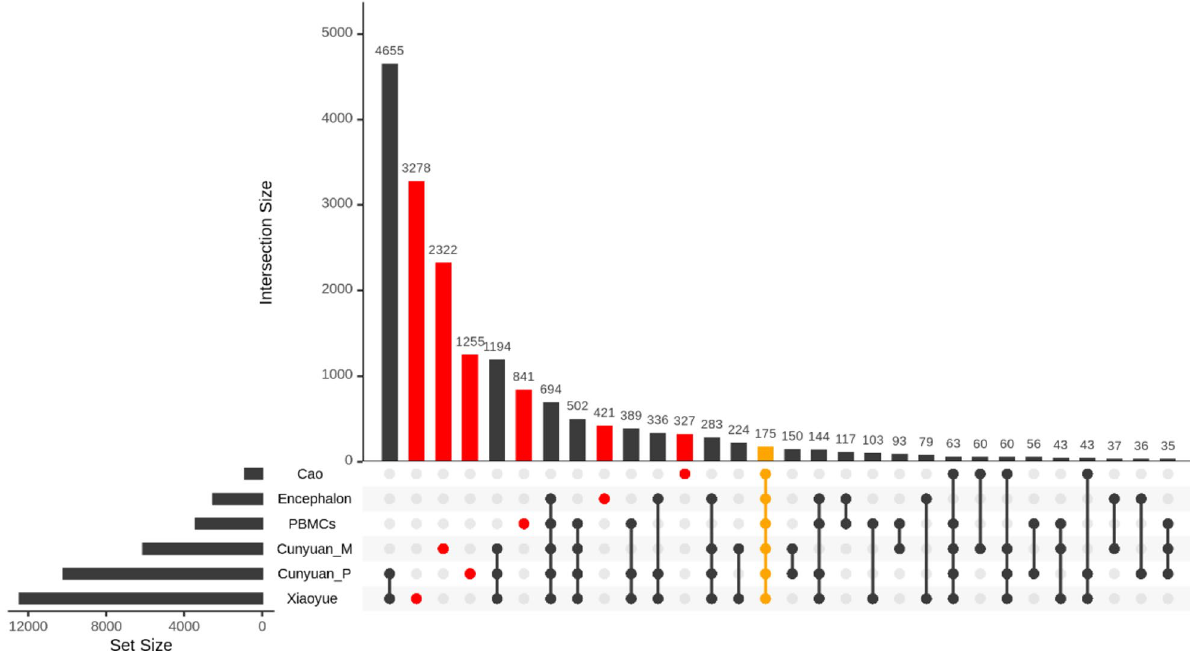
Figure 2. UpSet plot with the comparison of detected circRNAs in different studies. Encephalon and PBMCs refers to the circRNAs detected in this study, while Cunyuan_P (pituitary gland), Xiaoyue (pituitary gland), Cunyuan_M (longissimus dorsi muscle) and Cao (longissimus dorsi muscle) refers to the circRNAs detected in 45–48 , respectively. Cells filled with a dot indicate the circRNA is in the corresponding database, while empty cells indicate that the circRNA is not present in the corresponding database. In red the circRNAs that are exclusively expressed in one database and in orange the circRNAs common to all databases. Intersections with less than 30 elements were removed for visualization